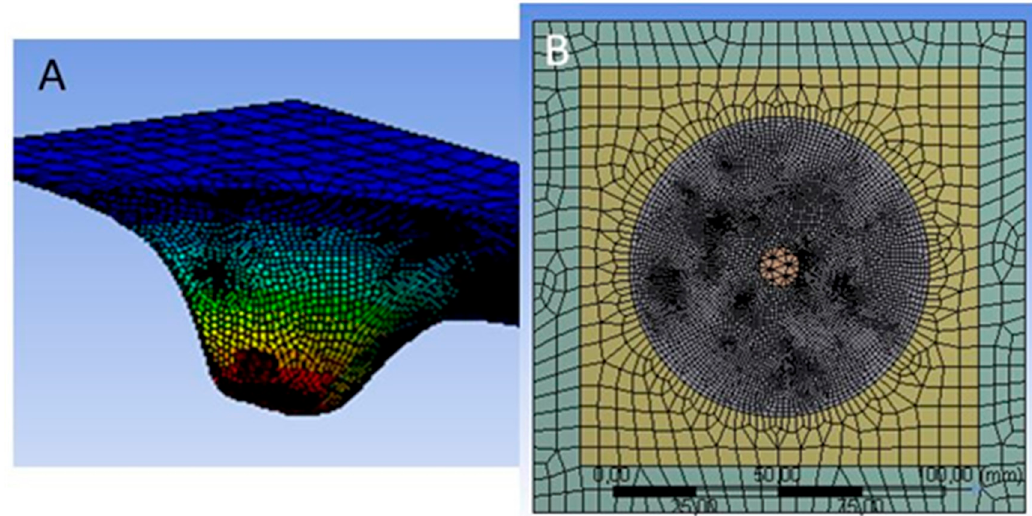
Figure 4. ( A ) General view of the Finite Element Method, FEM mesh. ( B ) Detail of the mesh.